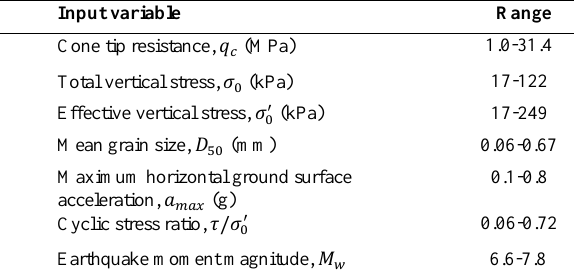
Table 1. Range of values associated with the input variables used in liquefaction